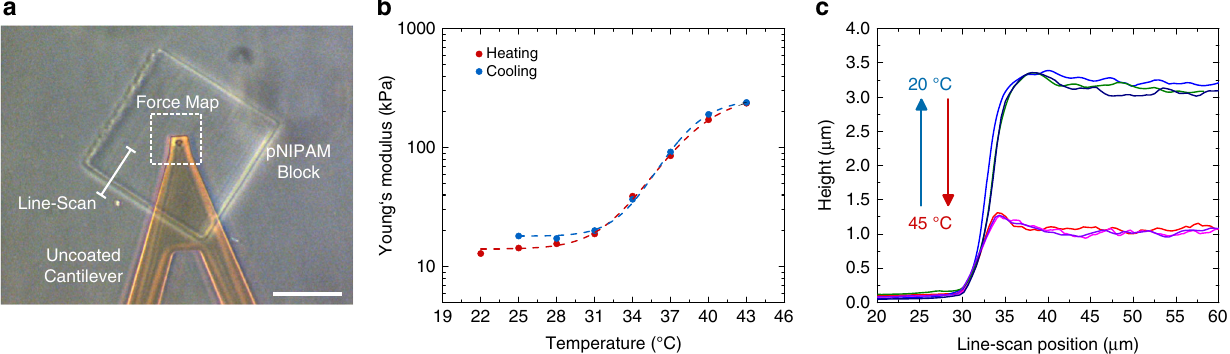
Fig. 1 Mechanical analysis of a pNIPAM block fabricated by 3D laser lithography. a Optical micrograph in the AFM with overlayed indications for the force measurements and the line-scan. Scale bar is 50 µ m. b Measured Young ’ s Modulus as a function of temperature for a stepwise heating and cooling of the sample. c Height measurement via line-scanning from the glass substrate on top of the pNIPAM block. The different colors depict several cycles of heating and